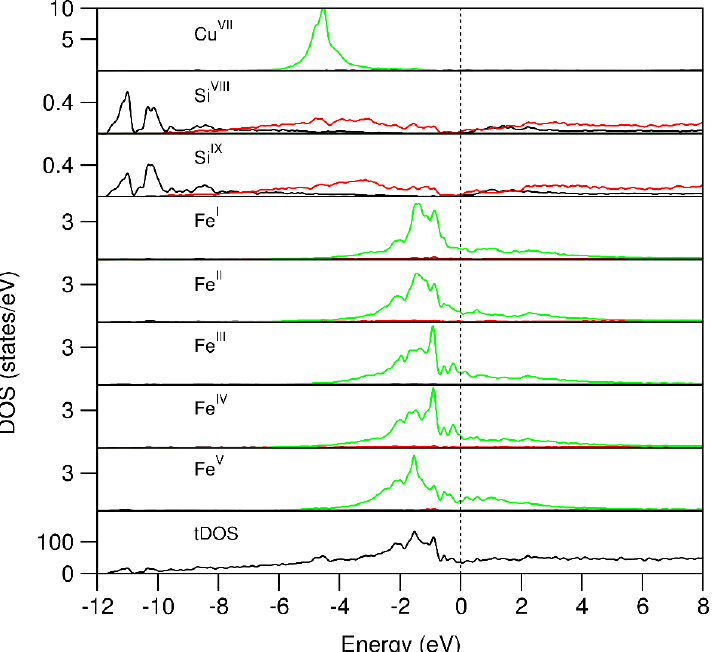
Figure 4. Partial density of states (pDOS) of the selected atoms in and the total density of states (tDOS) of θ -Al 68 Cu 2 Si 8 Fe 24 . The black lines for the pDOS of atoms represent s-characters, red p-characters and green 3d-characters. The vertical dotted line represents the Fermi level (at zero eV). We observed that the Fermi level is dominated by Fe 3d states.